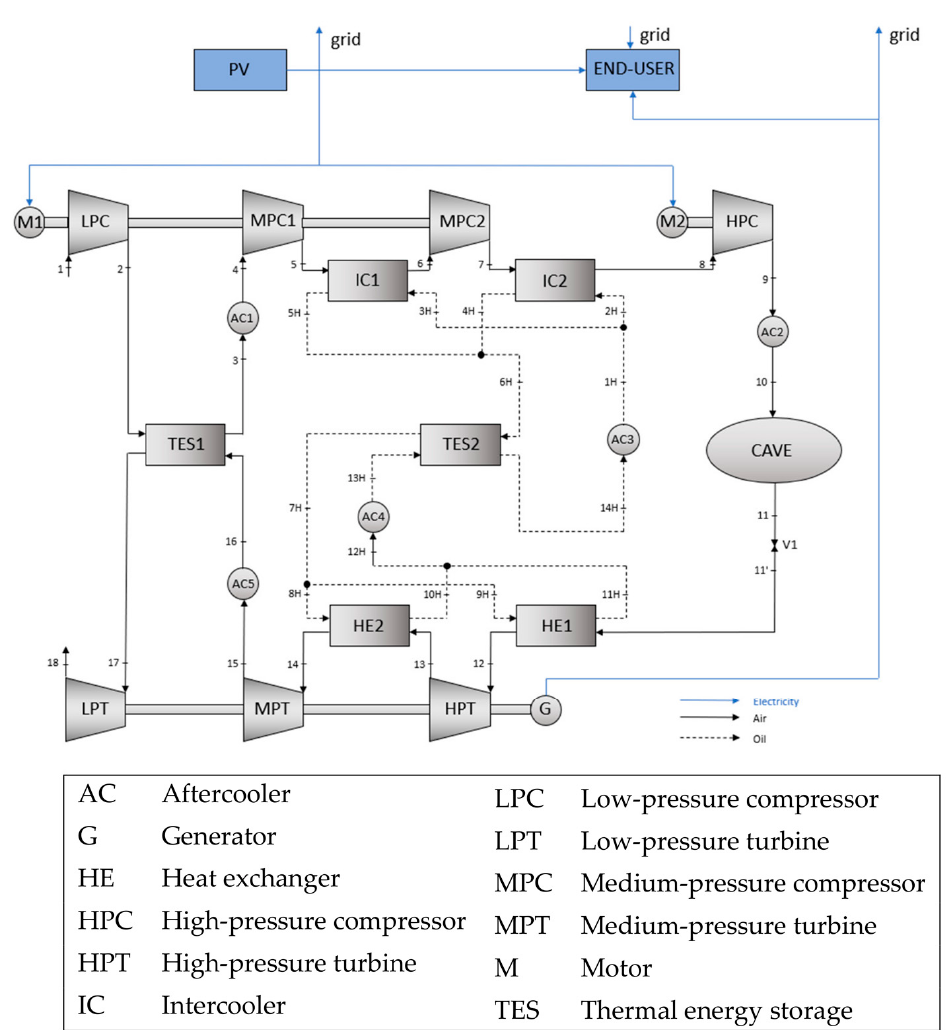
Figure 1. Schematic diagram of the PV-ACAES system.